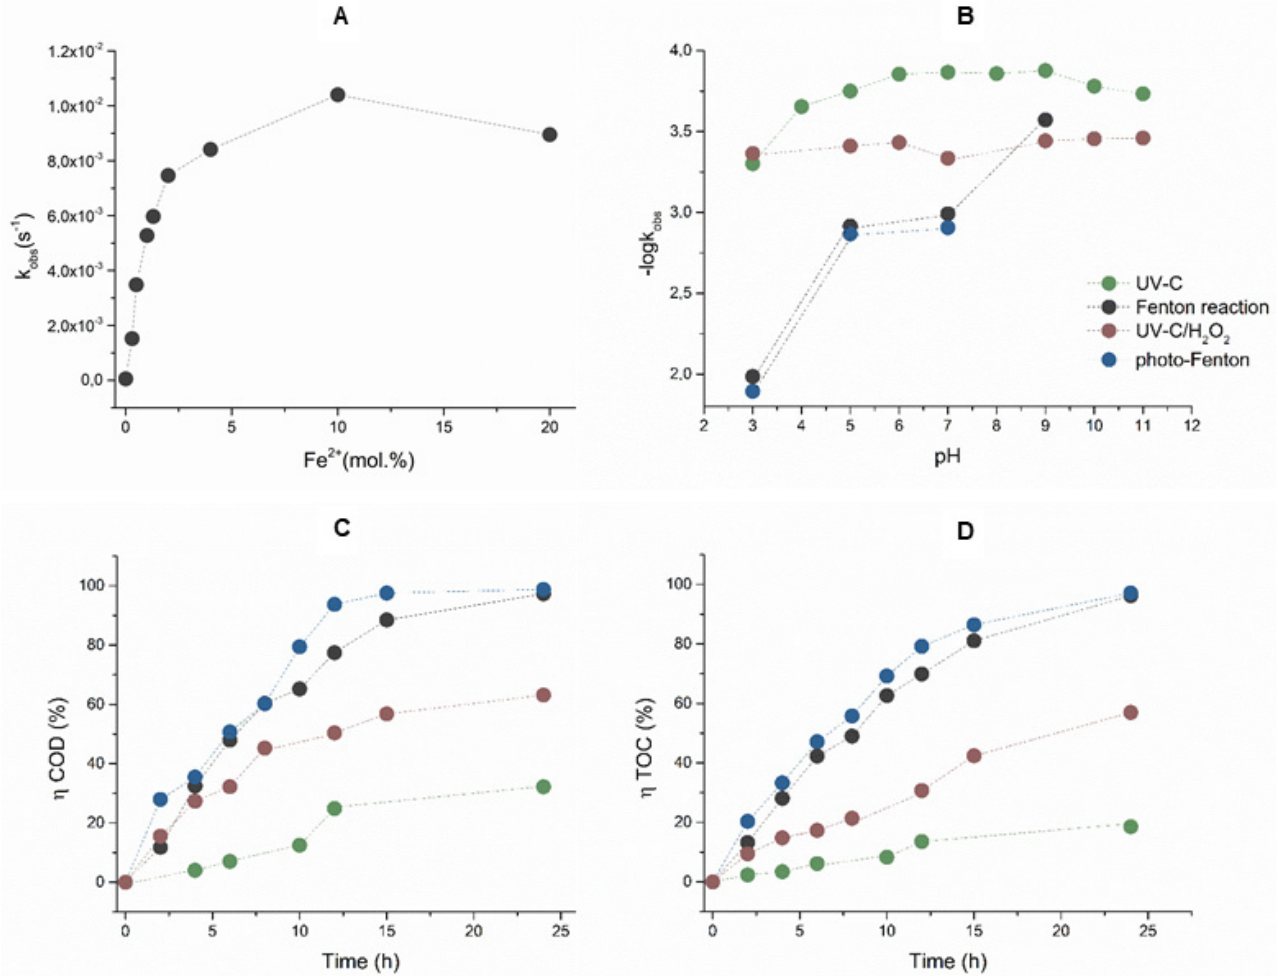
Figure 2. ( A ) Dependences of the observed first-order rate constant of the Fenton oxidation of AB80 on the molar ratio of Fe 2+ /H 2 O 2 at pH = 3, λ anal = 627 nm. ( B ) pH profiles of the H 2 O 2 /Fe 2+ , H 2 O 2 /Fe 2+ /UV, AB80/UVC, and UVC/H 2 O 2 reaction systems describing the reaction rates of AB80 decolorization in the homogeneous phase, λ anal = 627 nm. ( C ) The efficiency of AB80 oxidation at pH = 3 in the homogeneous phase for the applied reaction systems, is expressed by a relative reduction in COD. ( D ) The efficiency of AB80 mineralization at pH = 3 is expressed by a relative reduction in COD. The kinetic measurements were performed at t = 25 °C.